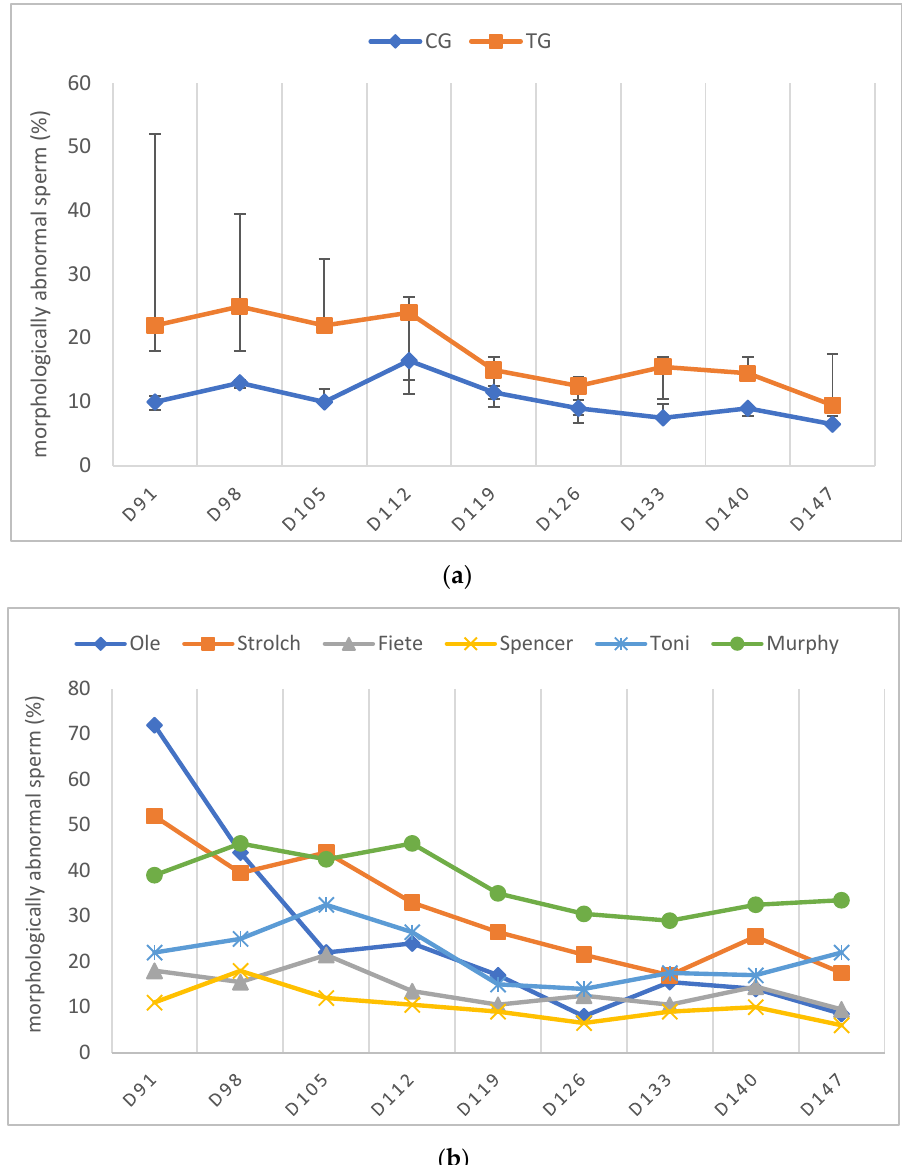
Figure 7. ( a ) Percentage of morphologically abnormal sperm given as median (Q1, Q3) over time of animals treated with a 4.7 mg deslorelin implant (TG, n = 5, excluding Murphy) and saline-treated control animals (CG, n = 3). ( b ) Percentage of morphologically abnormal sperm given as individual courses of animals treated with a 4.7 mg deslorelin implant (TG, n = 6) over time. Considering the dog with altered semen quality prior to treatment (Murphy), the first sperm were identified on D49. Changes over time in this dog are included in Figures 4b, 5b, 6b, 7b and 8b. VOL and TSC increased over time, but TSC only reached 178 × 10 6 spermatozoa at the end of the study. In total, the semen quality was restored to pre-treatment levels, with oligozoo- and teratozoospermia still being present after treatment and